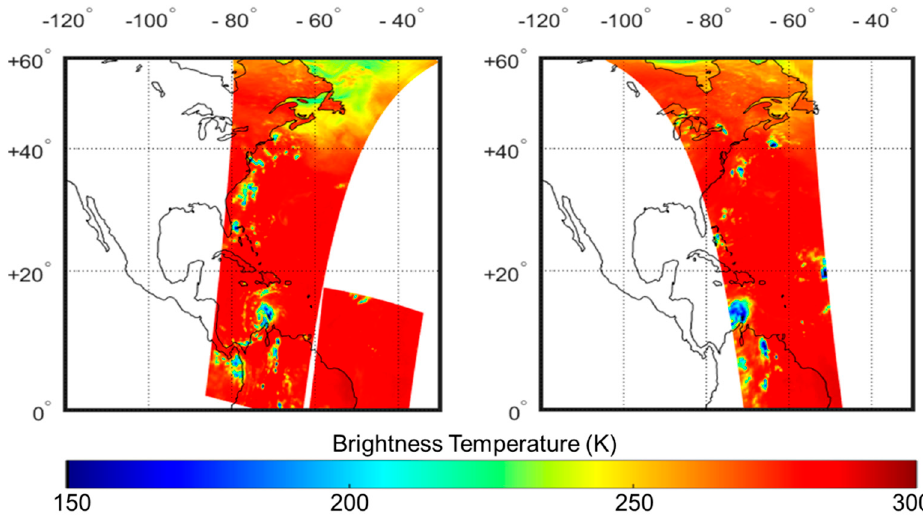
Figure 6. Schematic of matching between FY-3C MWHTS and WRF output (for 150 GHz channel). The matching threshold is 0.25° for latitude and longitude and 30 min for time. The matched pixels are based on MWHTS since the WRF output is gridded with high temporal and spatial resolution as the model configured.